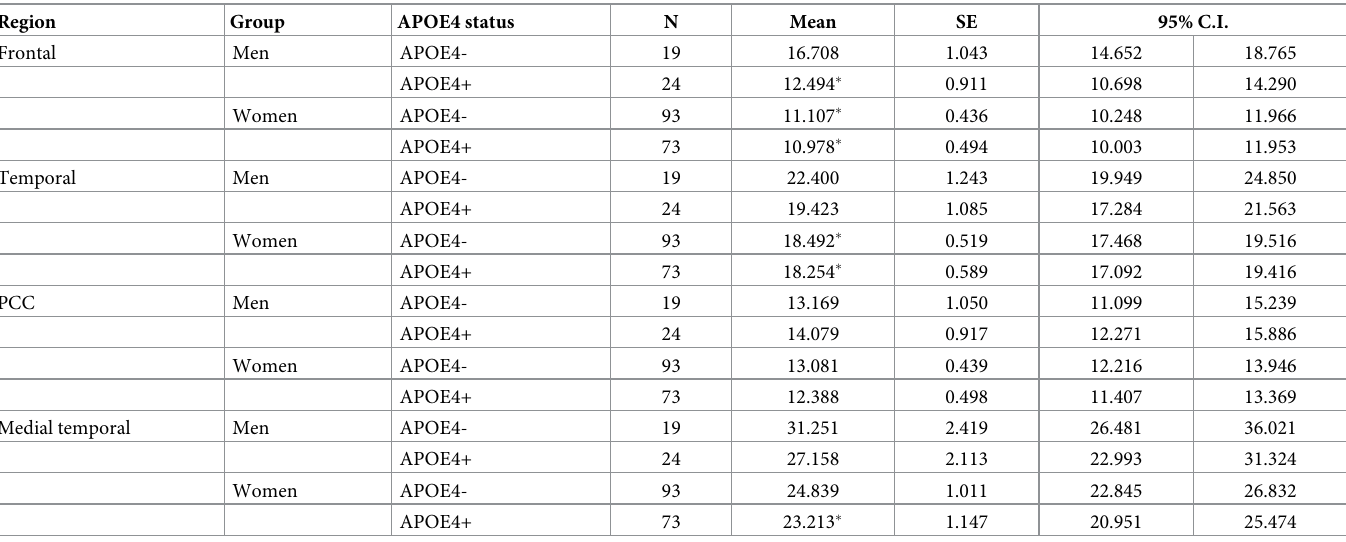
Table 3. Regional PCr/Pi by sex and APOE4 status.